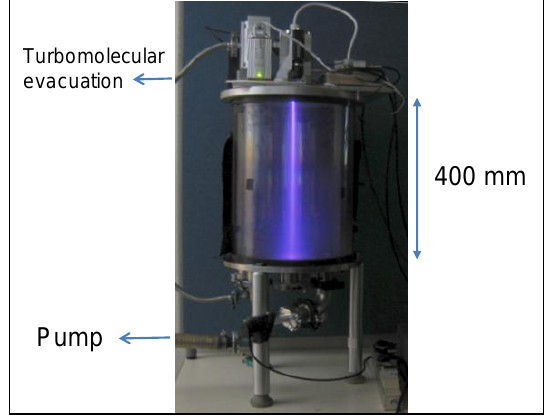
Figure 6. Emission of a beam in the transparent vacuum chamber.